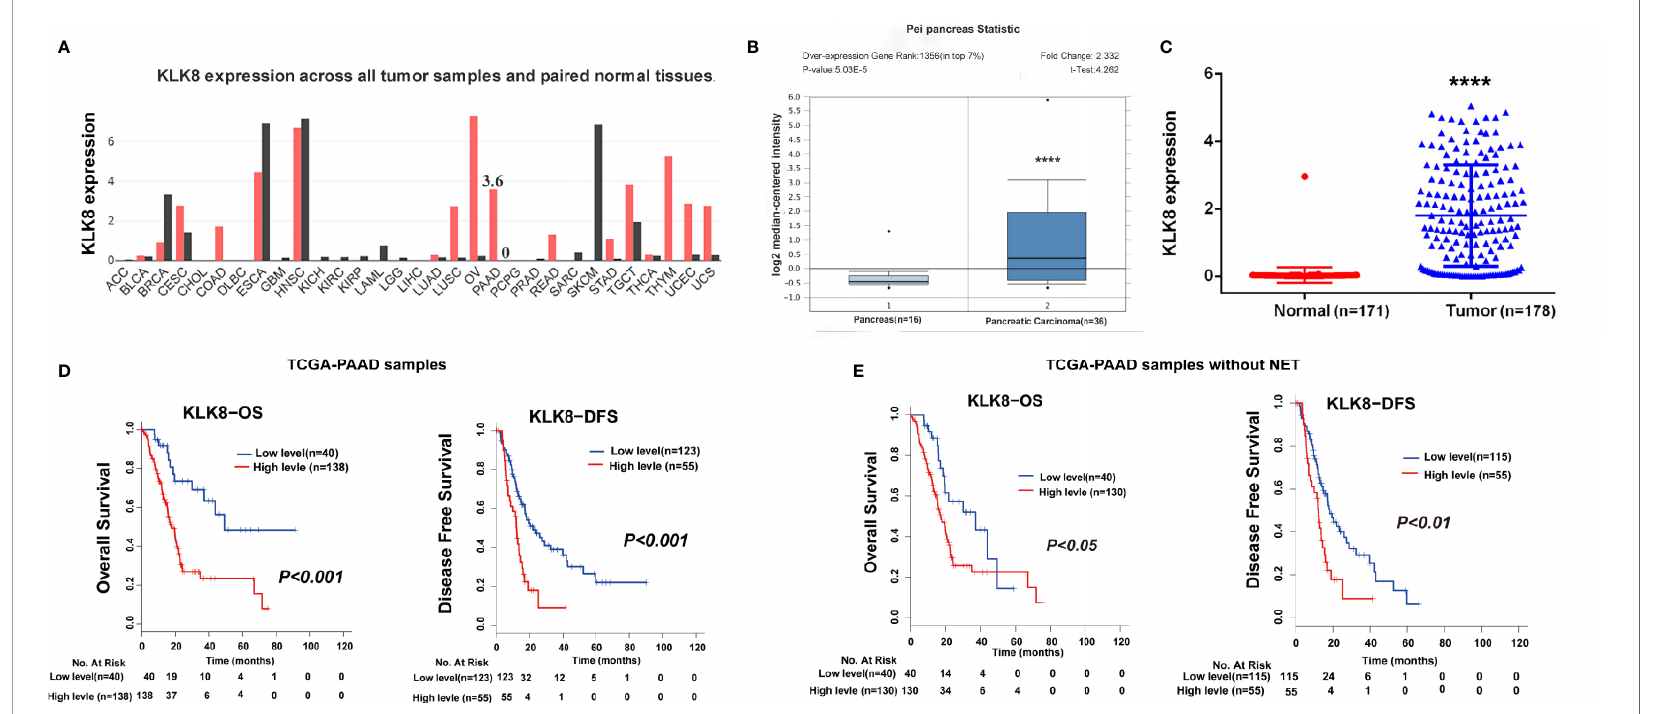
FIGURE 1 | KLK8 was associated with PDAC tumorigenesis and prognosis in the TCGA-PAAD cohort. (A) KLK8 expression in different cancers and their paired normal tissues in the GEPIA. The height of bar represents the median expression of certain tumor type or normal tissue. (B) KLK8 expression of normal specimens and pancreatic carcinoma from an independent pancreatic dataset in the Oncomine database. The expression fold-change was 2.332. (C) In the TCGA-PAAD cohort, KLK8 was more signi fi cantly expressed in cancer patients (n=178) than in normal controls (n =171). (D) The TCGA-PAAD database has 178 pancreatic cancer samples, including 8 pancreatic neuroendocrine tumor (NET) samples. Overall survival (OS, left panel) and Disease-free survival (DFS, right panel) were compared between patients with low and high KLK8 expression in the TCGA-PAAD cohort (n=178). (E) We deleted these 8 NETs, and the remaining cohort consisted of 170 primary PDACs samples (TCGA-PAAD cohort without NETs, n=170) were used for performing the survival analysis. OS (left panel) and DFS (right panel) was compared between patients with low and high KLK8 expression. ****p < 0.0001 vs